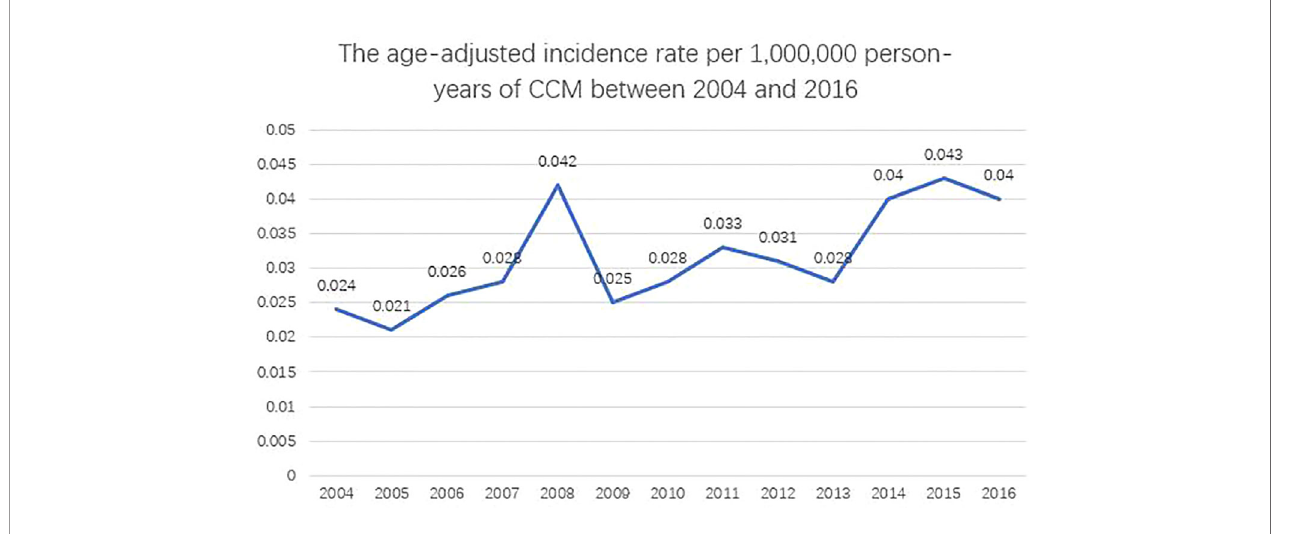
FIGURE 1 | The age-adjusted incidence rates of the central nervous system clear cell meningioma between 2004 and TABLE 1 | Demographic and clinical characteristics of patients with CCM.